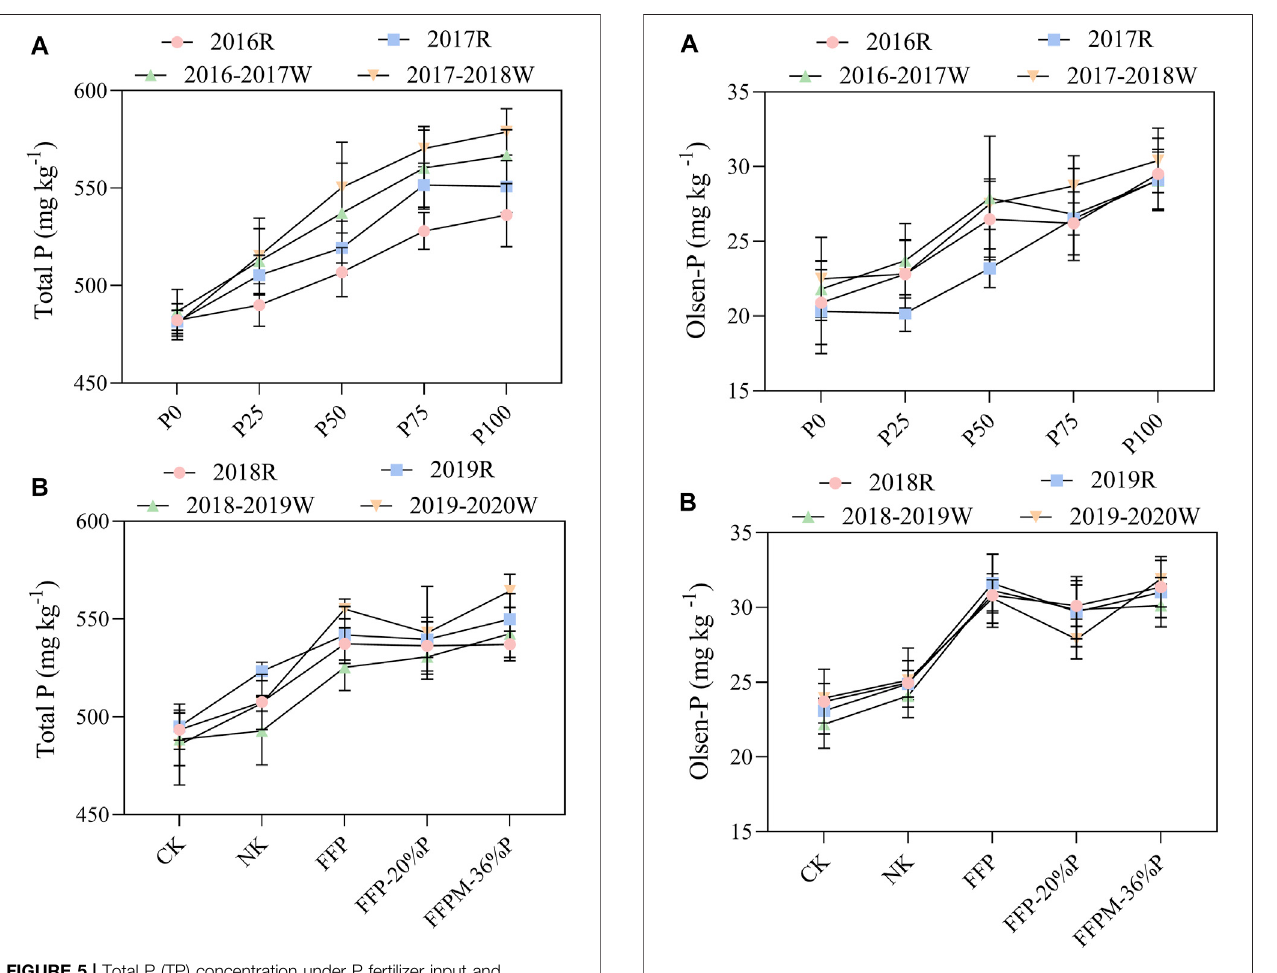
Frontiers in Environmental Science |